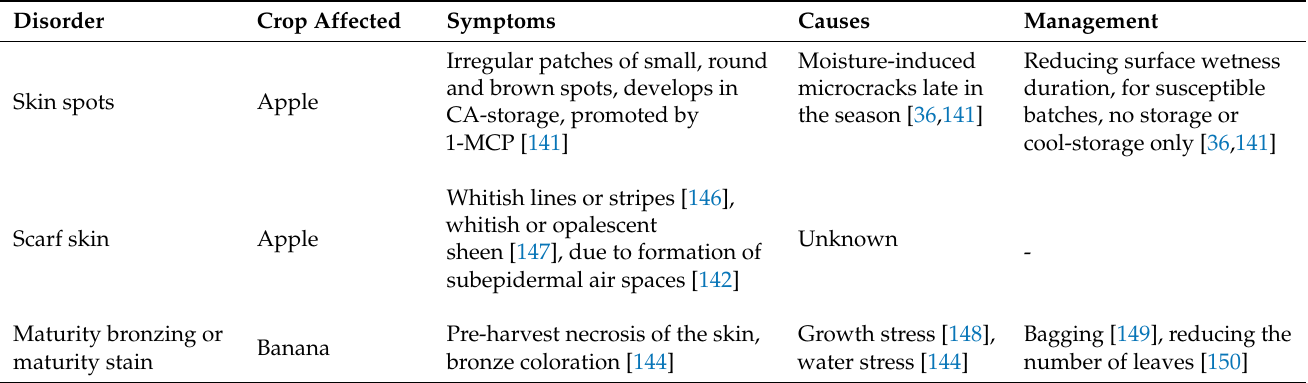
Table 2. Fruit surface disorders that bear some similarity with russet, but where no periderm is involved. Data are compiled from literature